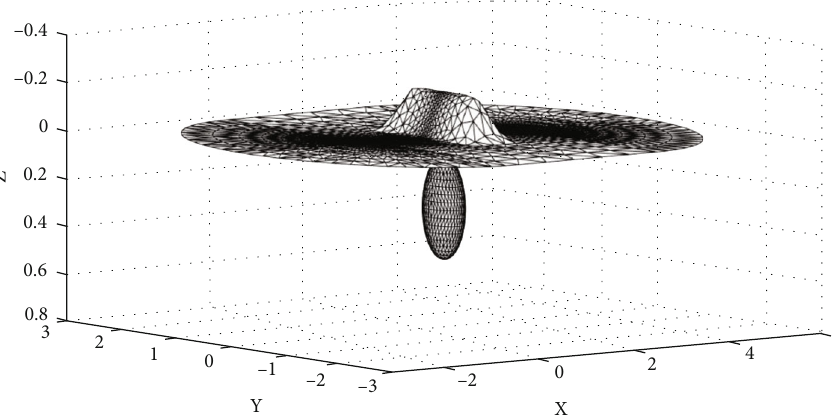
Figure 1: 3D model of the computational mesh for simulating the electric fi eld by IEM for the medium with the ground surface topography and immersed inhomogeneity.